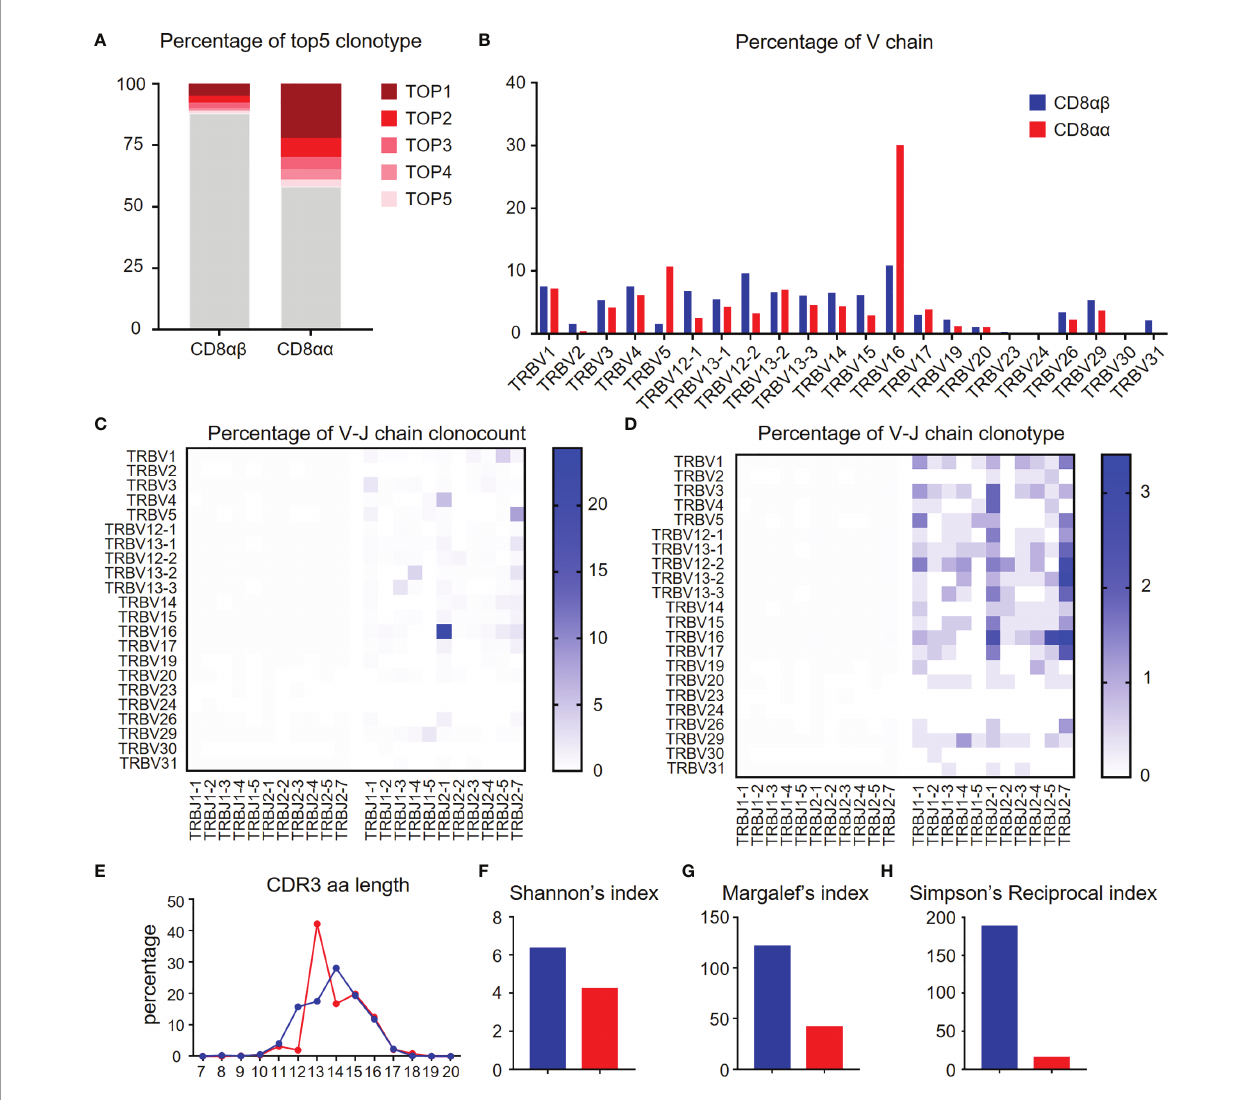
FIGURE 6 | Diversity of TCR repertoire of hepatic CD8 aa and CD8 ab T cells of TG mice. (A) Percentage of the top 5 TCR b -chain clonotypes in CD8 ab and CD8 aa T cells from TG mice. (B) Frequency of functional V chains in CD8 ab and CD8 aa T cells from TG mice. (C, D) Heat-maps of TCR b -chain V-J pairing usages in count (left) and type (right) for CD8 ab (left) and CD8 aa (right) cells from TG mice. (E) CDR3 repertoire amino acid (AA) length distribution of TCR b chain in CD8 ab and CD8 aa cells from TG mice. (F – H) Diversity index of TCR b -chain repertoires in CD8 ab and CD8 aa cells from TG mice, including Shannon ’ s index (F) , Margalef ’ s index (G) and Simpson ’ s Reciprocal index (H)